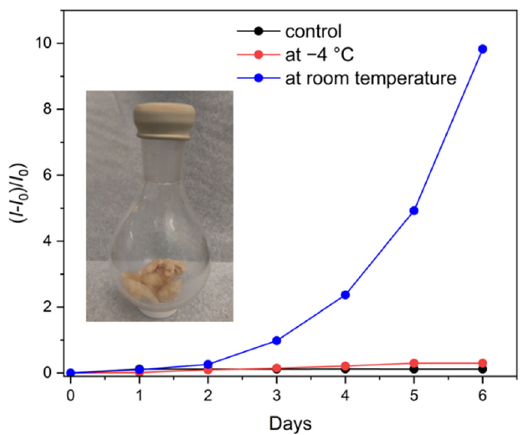
Figure 7. Relative fluorescence intensity changes of APBI-Cu nanorod sensor at different conditions toward sulfide during a 6-day period of chicken meat spoilage process. Inset showing the round bottom flask used for storage of meat samples.